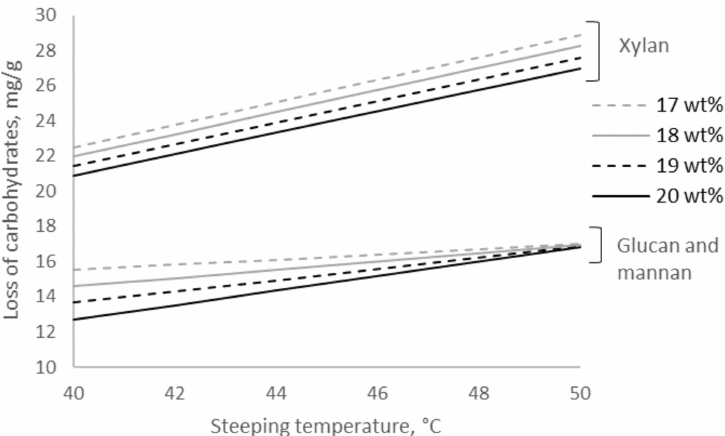
Figure 2. Modeled loss of carbohydrates in the residue after extraction of pulp with aqueous NaOH at di ff erent concentrations and